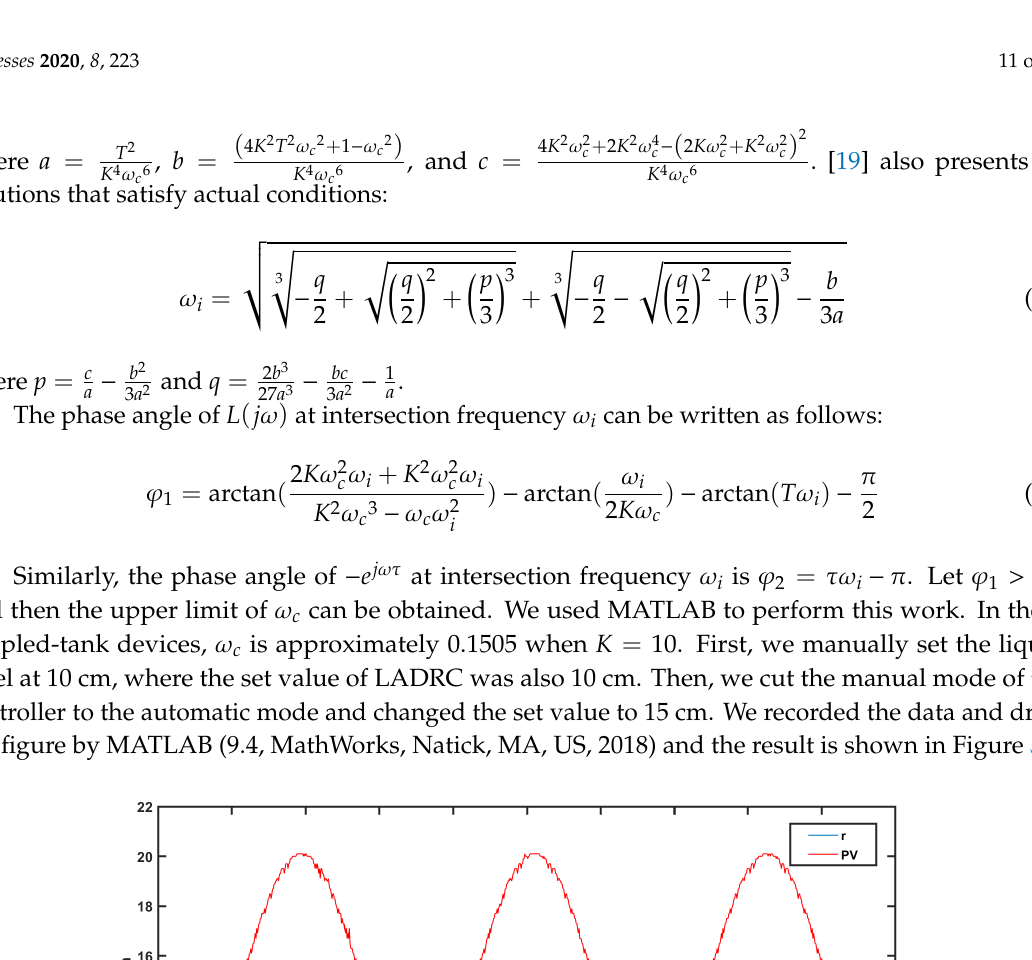
ω c = 0.1505 and K